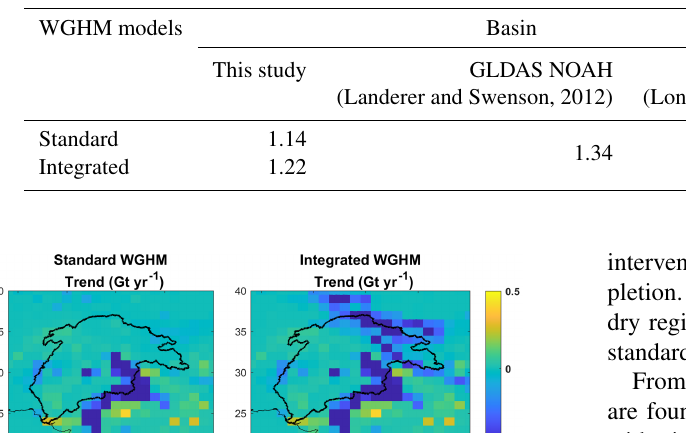
Table 3. Basin-scale factors and frequency-dependent scale factors for the Indus Basin. Basin-scale factors from two different studies are given for reference.